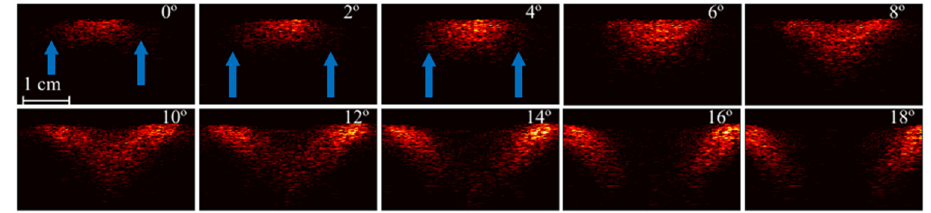
Figure 7. PA subframes of the homogeneous phantom for increasing illumination angles in the range 0°–18°. Each subframe is an average of the phantom’s elevational dimension (i.e., 3.8 cm). Blue arrows indicate the generation of PA signals beyond the laser focal region.